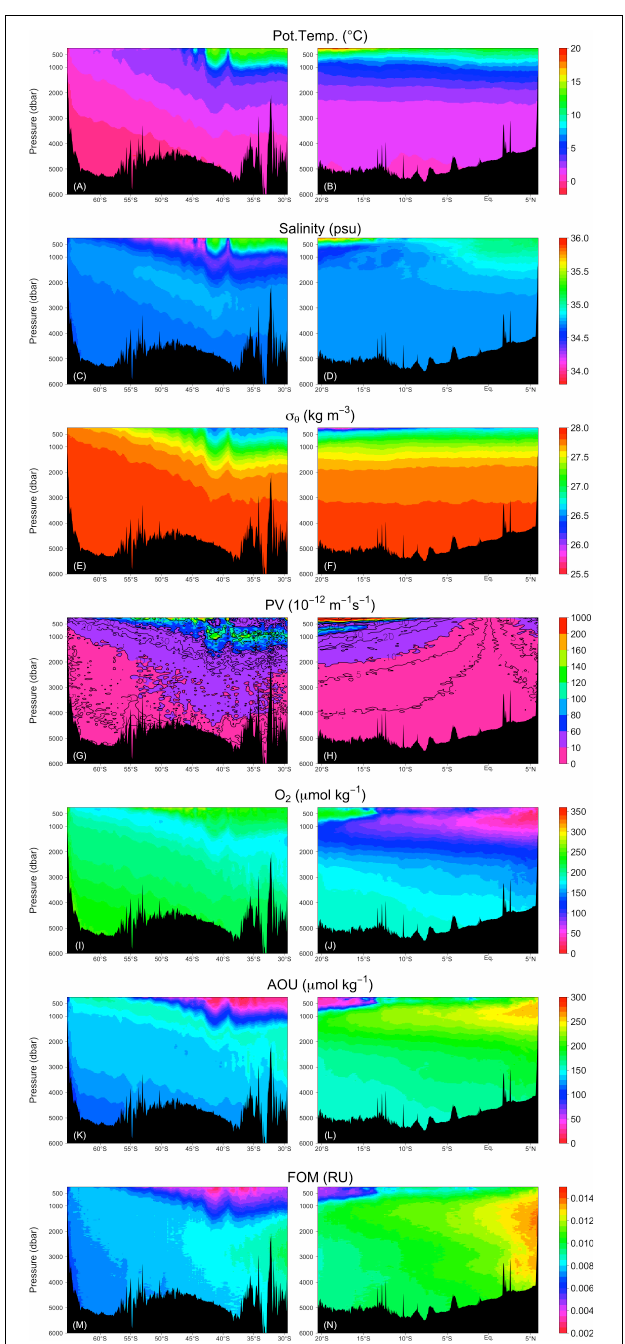
FIGURE 6 | Vertical sections of (A,B) potential temperature, (C,D) salinity, (E,F) σ θ , (G,H) absolute value of PV, (I,J) dissolved oxygen, (K,L) AOU, and (M,N) FOM. Right and left columns represent the Leg 2 and Leg 3 transects, respectively.